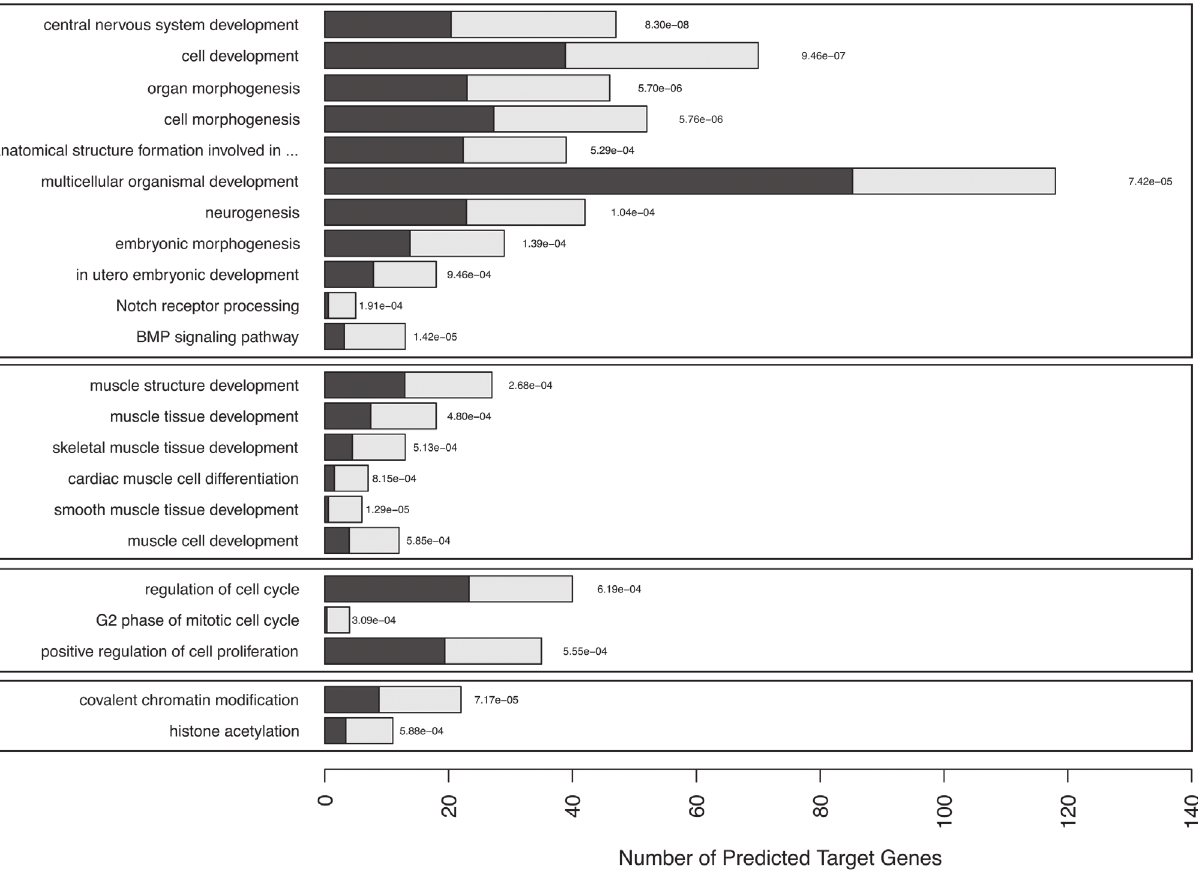
Figure 6. Overrepresented gene ontology-related biological processes in FSHD muscle. Graphical representation of the selected enriched biological processes (BP) from the list of putative target-genes based on Gene Ontology annotation. Dark bars: expected count of putative target-genes in each BP; light bars: observed BP enrichment; and, values alongside the bars. The overrepresentation was assessed with a statistical score based on a hypergeometric tests with p-values (cid:1) 0.001.